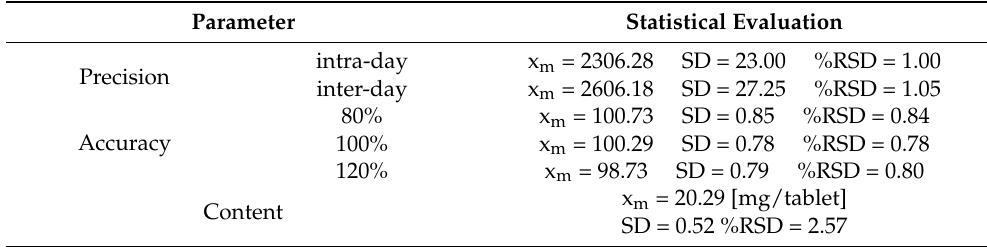
Table 2. Results of method validation and determination of grapiprant in pharmaceutical preparation.